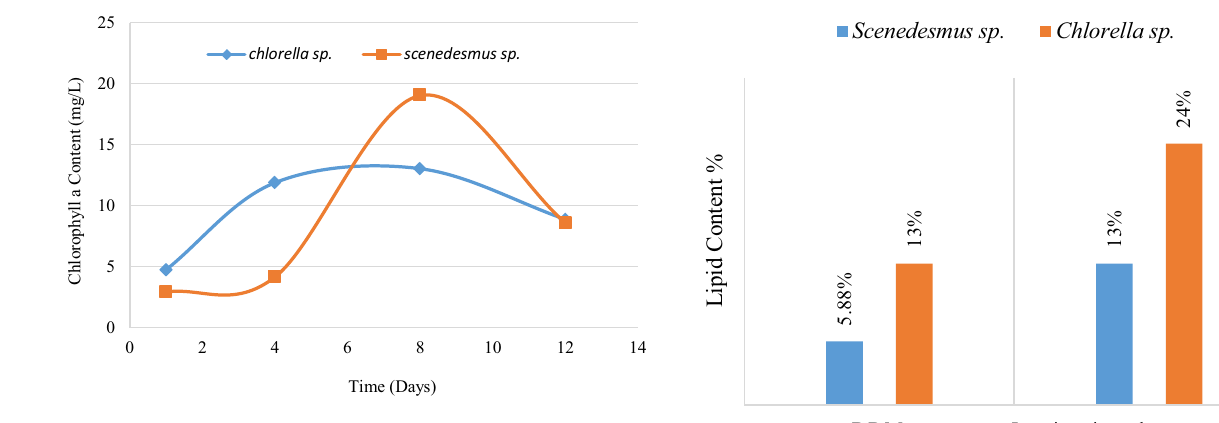
Fig. 2 Chlorophyll a content of isolated microalgae in a wastewater sample